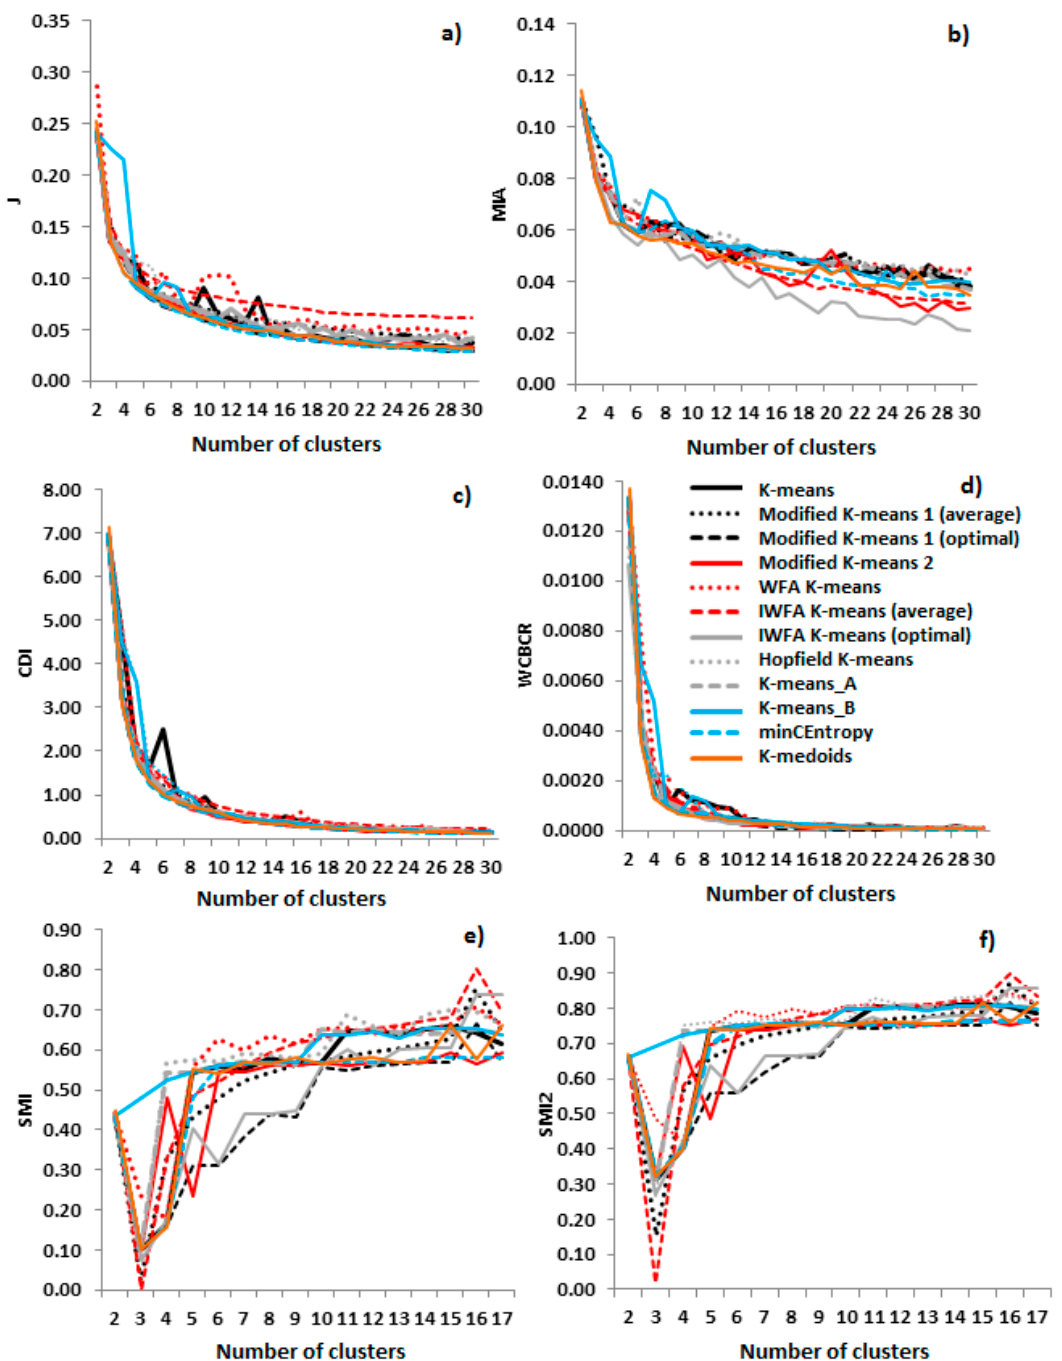
Figure 1. Comparison of the partitional algorithms using: ( a ) J, ( b ) MIA, ( c ) CDI, ( d ) WCBCR, ( e ) SMI, ( f ) SMI2.